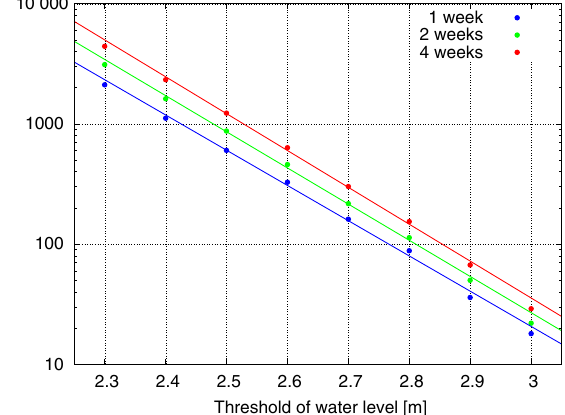
Figure 8. Number of occurrences N in which the threshold y is exceeded twice within 1, 2 or 4 weeks (blue, green and red respec- tively). The vertical axis is